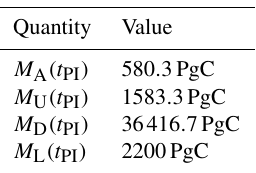
Table 2. Initial equilibrium pre-industrial conditions obtained for the parameters specified in Table